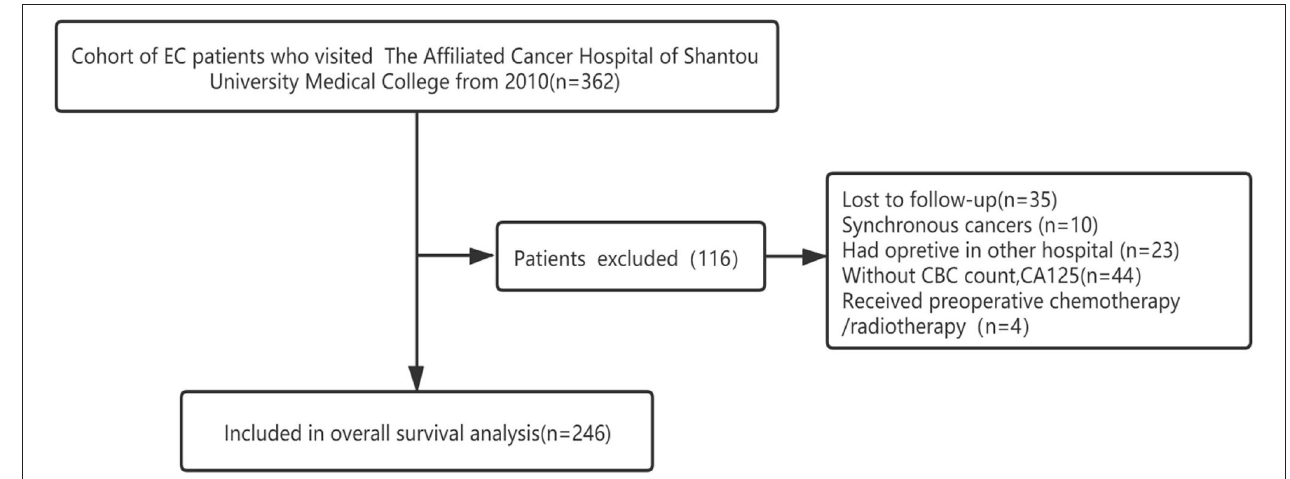
FIGURE 1 | The flowchart of the enrollment